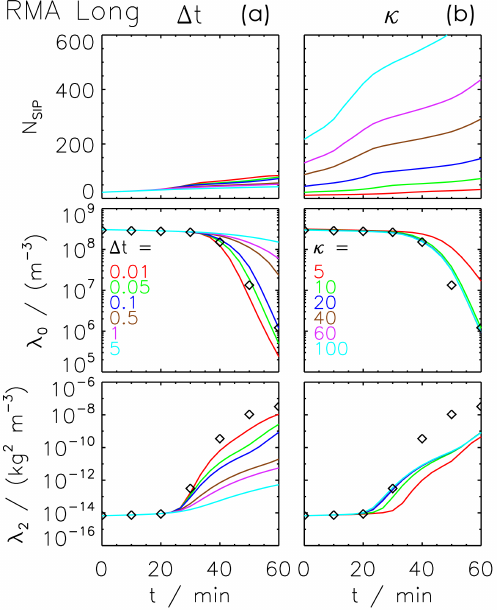
Figure 8. SIP number and moments λ 0 and λ 2 as a function of time obtained by RMA for the Long kernel. The black diamonds show the reference solution. The curves depict the RMA results (en- semble averages over 50 realisations). The default settings are the RedLim version with e γ 0 . 1, singleSIP-init with weak threshold = η 10 − 8 , κ 10 ,(cid:49)t 1s and r critmin 5 . 0µm. The left column = = = = shows a variation of (cid:49)t (see legend), the right one a variation of κ (see